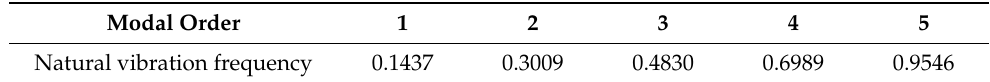
Table 2. Natural vibration frequency of the riser